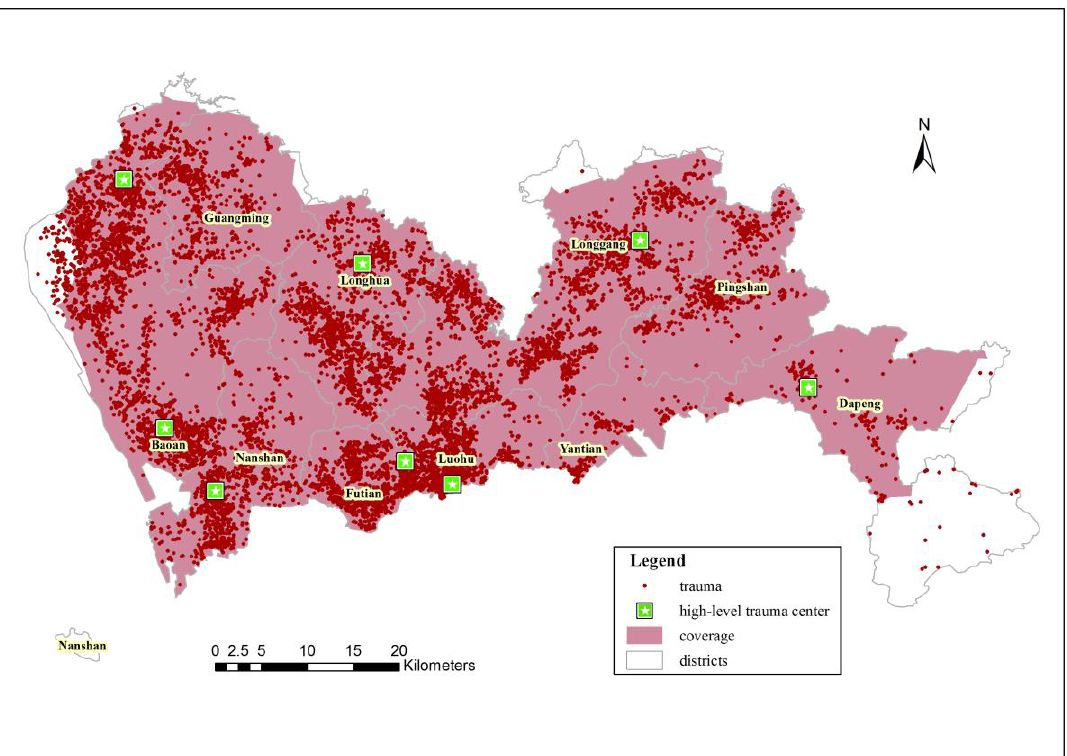
Figure 9. Location results of high-level trauma centers.